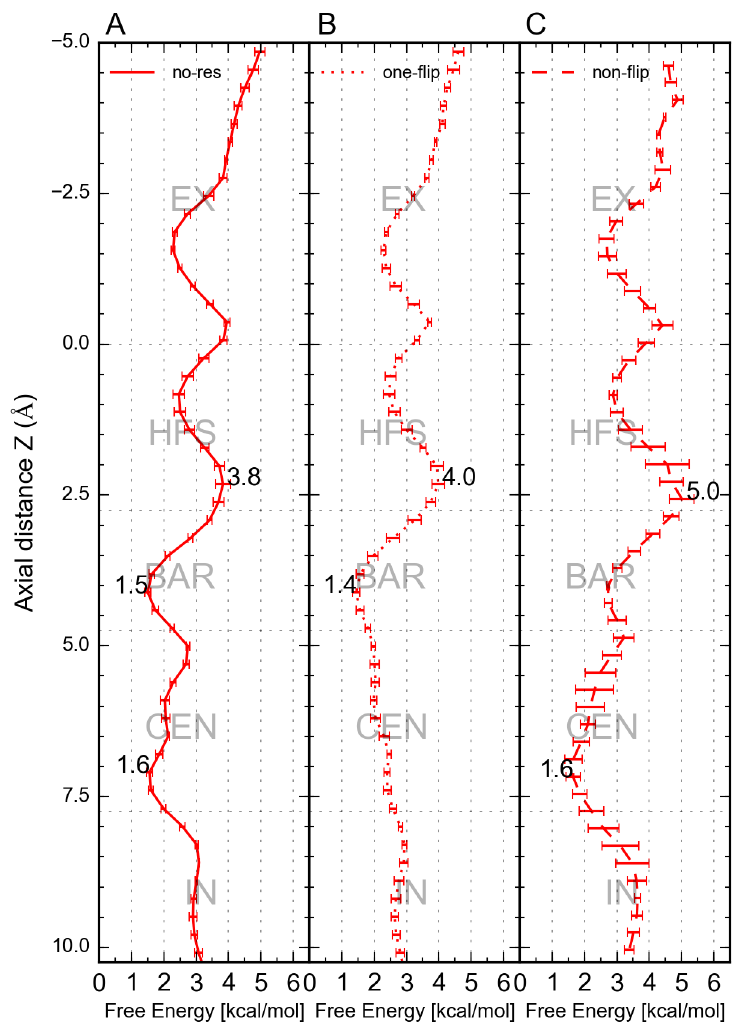
Figure 9. PMF comparison for outward conduction. A) PMF of the simulations without restraints of E53 is depicted as solid line. (B) PMF of the simulations with ‘‘one-flip’’ restraints. C) PMF of the simulations with ‘‘non-flip’’ restraints. The largest free energy barriers in each figure are labeled by terminal peaks and wells. Error estimations shown in the figure are S.E.M.